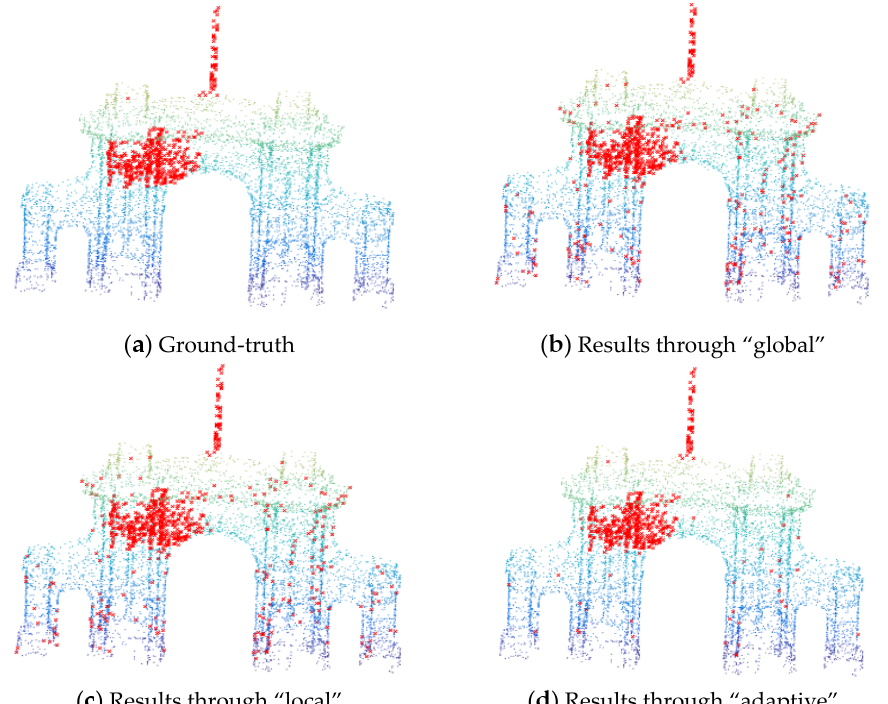
Figure 7. Qualitative comparison of 3D change detection via the three approaches. Red points represent change regions. ( a ) Ground-truth of change points; ( b ) results of change detection through “global”; ( c ) results of change detection via “local”; and ( d ) results of change detection via “adaptive”.